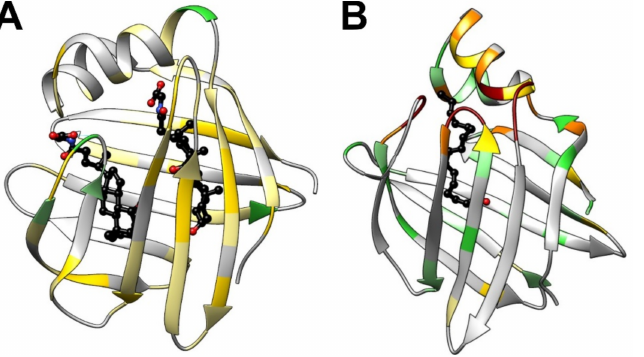
Figure 5. Differences in the generalized order parameter (S 2 ) characteristic of the amplitude of the ps- ns motion of backbone amide NH bond vectors upon ligand binding mapped on the ribbon diagram of ( A ) the doubly ligated complex of human ileal BABP (hI-BABP:GCA:GCDA, PDB: 2mm3 [25]) and ( B ) the complex of rat intestinal FABP with palmitate (PDB: 2ure [59]). Color coding: 0.5 < S 2 holo - S 2 apo in red, 0.25 < S 2 holo - S 2 apo < 0.5 in orange, 0.1 < S 2 holo - S 2 apo < 0.25 in gold, 0.05 < S 2 holo - S 2 apo < 0.1 in khaki, − 0.1 < S 2 holo - S 2 apo < 0.05 in pale green, S 2 holo - S 2 apo < − 0.1 in